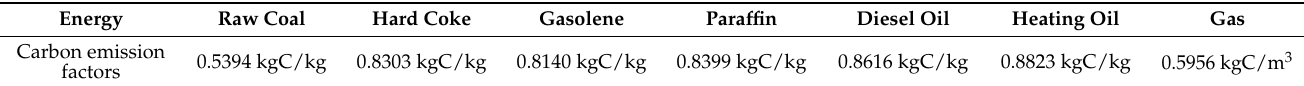
Table 1. CO 2 emission factors of various energy sources.